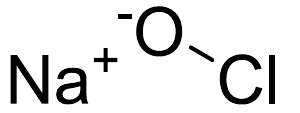
Figure 1. Structural formula of sodium hypochlorite.